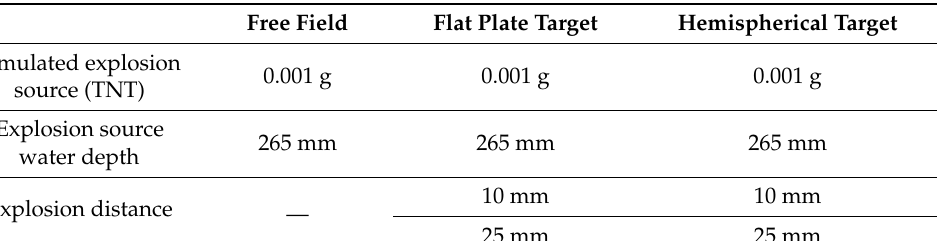
Table 1. Numerical model statuses.